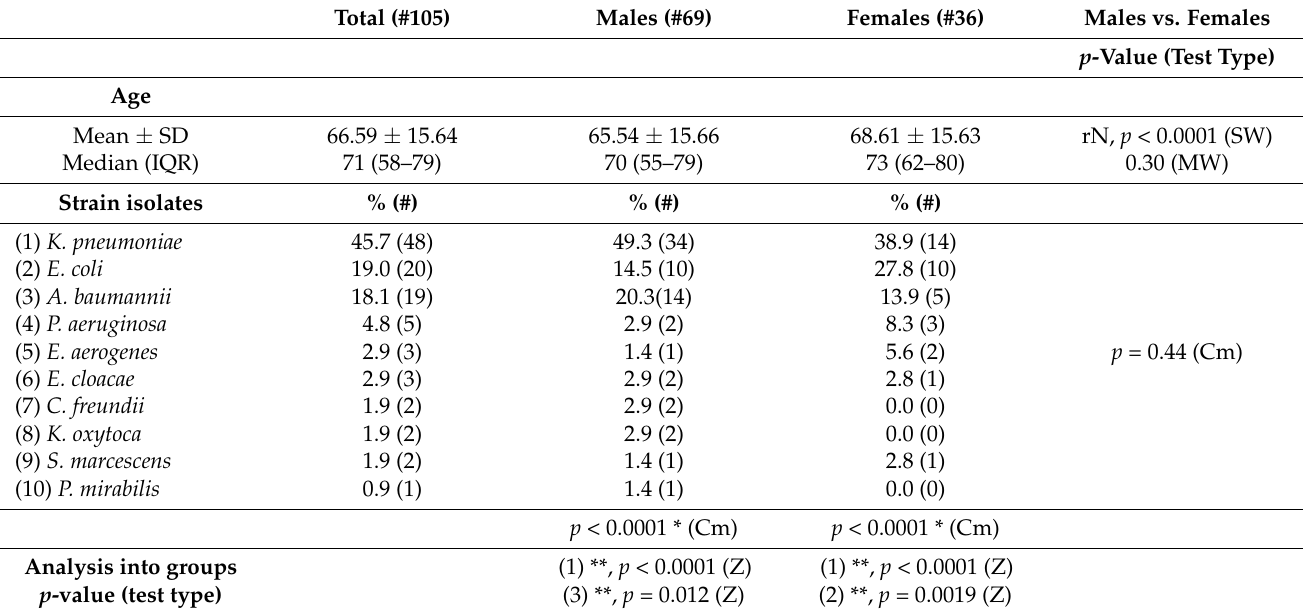
Table 1. Relationship between 105 strains isolated in blood culture and gender. Total (#105) Males (#69) Females (#36) Males vs.